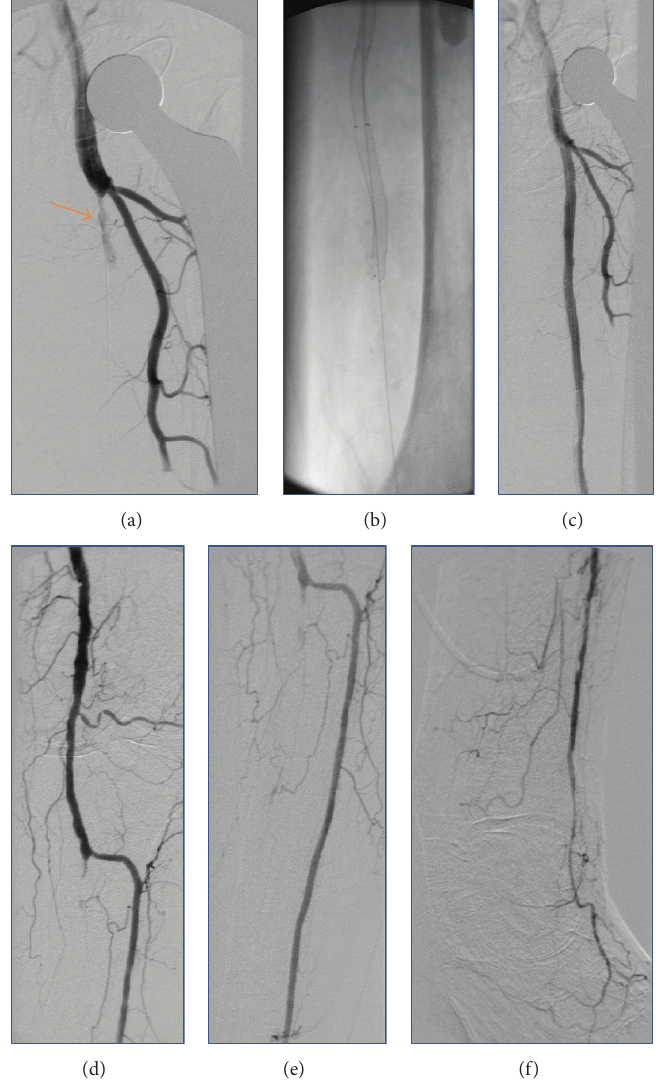
Figure 3: During the second angiographic session, DSA reveals not only complete resolution of the thrombus in the CFA (a) but also reocclusion of the SFA (orange arrow in (a)), requiring repeated Rotarex thrombectomy and implantation of further self-expanding nitinol stents (b). Subsequently, good angiographic flow can be achieved in the SFA and in the popliteal artery with a 1-vessel run-off of the anterior tibial artery